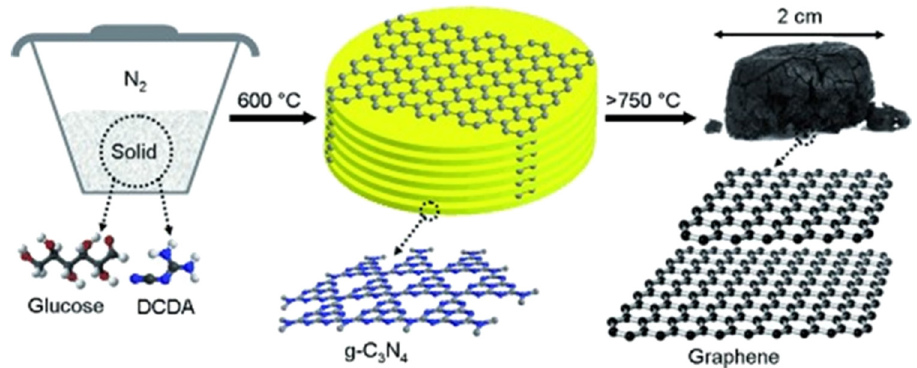
Figure 6: Proposed synthesis method for free - standing G. Bottom: repetition motifs of an ideal g - C 3 N 4 plane ( middle ) and of G ( right ) ; C is indicated by black or gray, N is indicated by blue. Copyright © 2012, Wiley Publishing Group [ 387 ] .